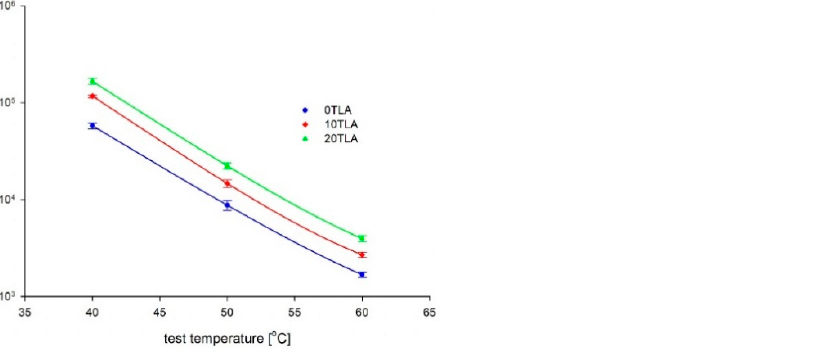
Figure 12. Creep curves for TLA-modified binders at ( a ) 40 °C; ( b ) 50 °C; ( c ) 60 °C.